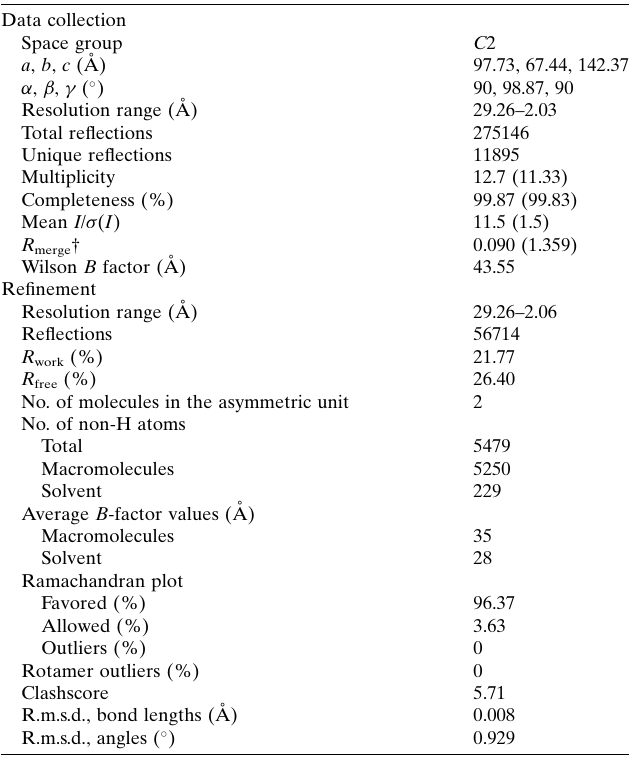
Table 1 Data-collection and refinement statistics. Values in parentheses are for the outermost resolution